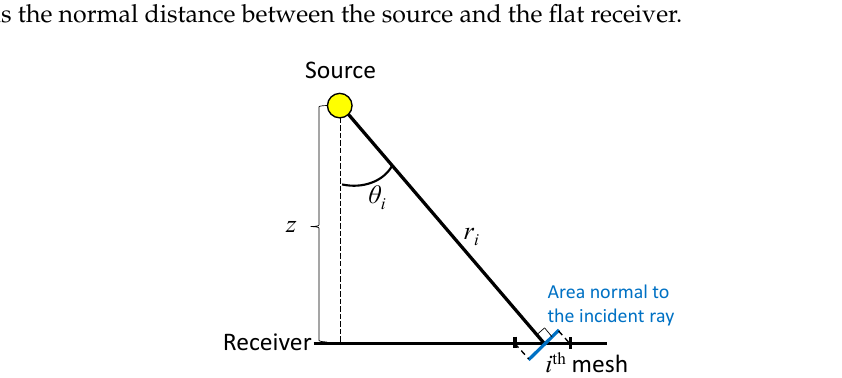
Figure 2. Schematic representation of the conversion between the illuminance and luminous